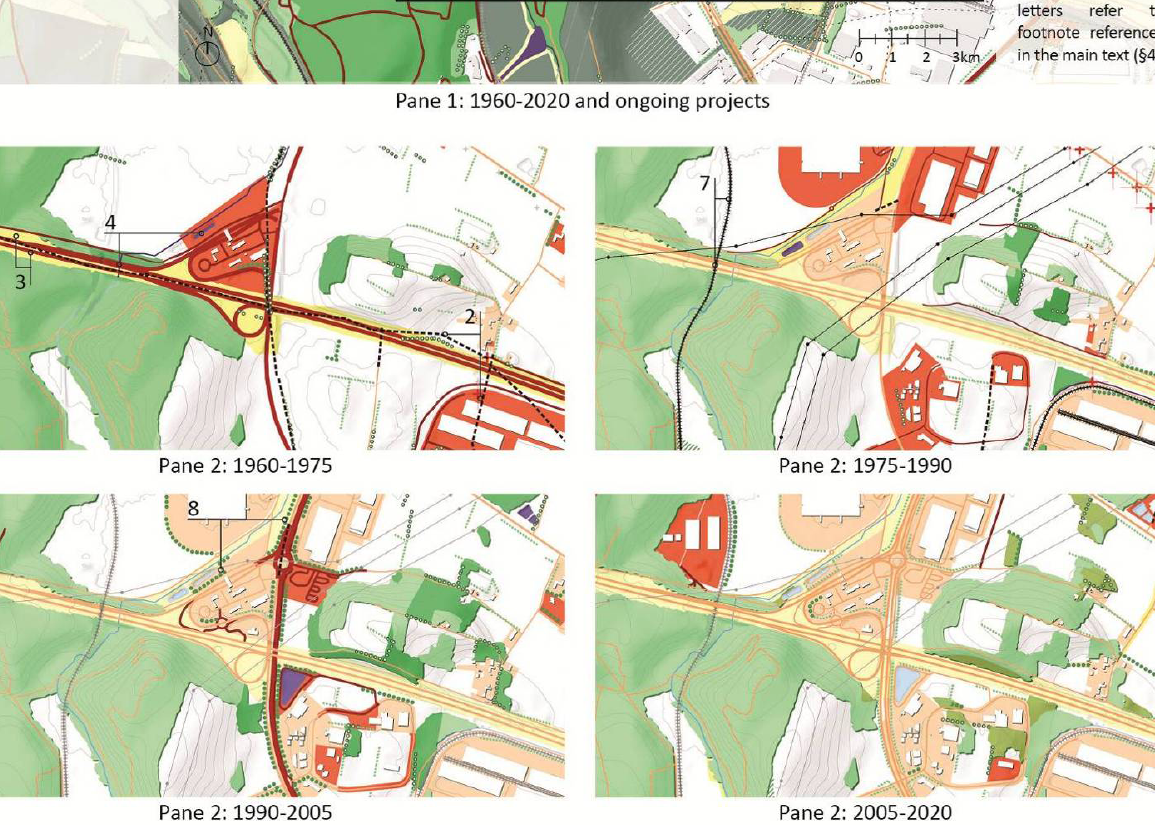
Urban Planning, 2020, Volume 5, Issue 2, Pages